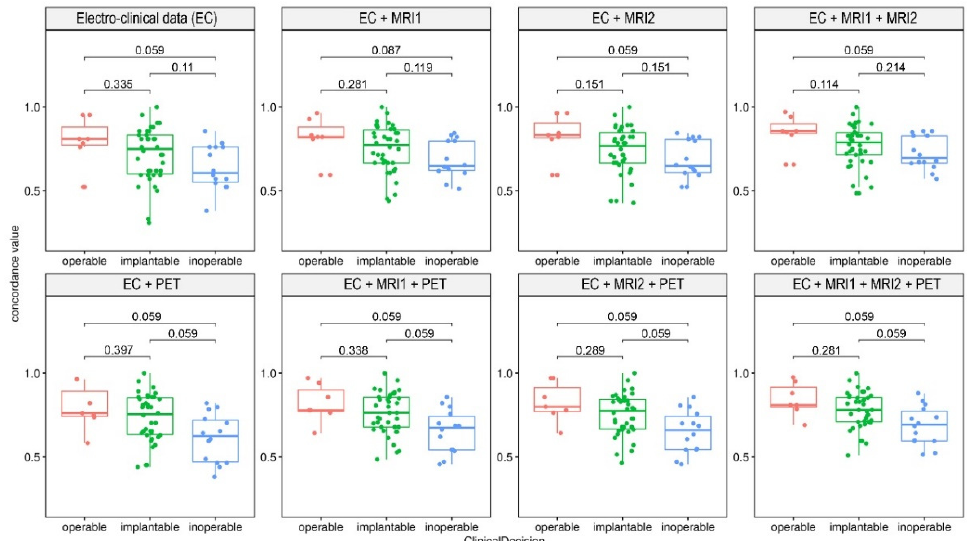
Figure 2. Clinical data concordance (CDC) of “Grouping Method 1.” Boxplots of the eight CDCs grouped by three-way clinical decisions. PET-related measurements showed a slight, but not significant, difference between the “inoperable” versus the “operable” or the “implantable” groups, while PET-independent methods showed relatively less accuracy. Analyzed by Mann–Whitney tests with FDR-correction, p -values are shown on the intervals in the charts.